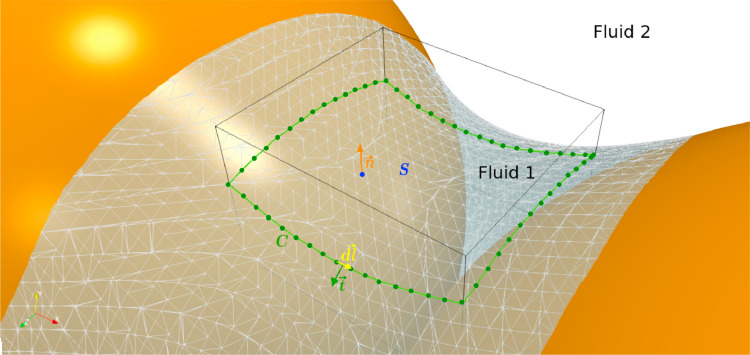
Fluid-fluid interface deformed due to surface tension. Mean curvature is determined by performing a force balance in a volume element V. Surface Sand contour Cresult from the intersection between Vand the interface. nrepresents the unit outward vector normal to S,dlthe unit vector tangent to Cand tthe unit vector normal to Cand tangent to S.